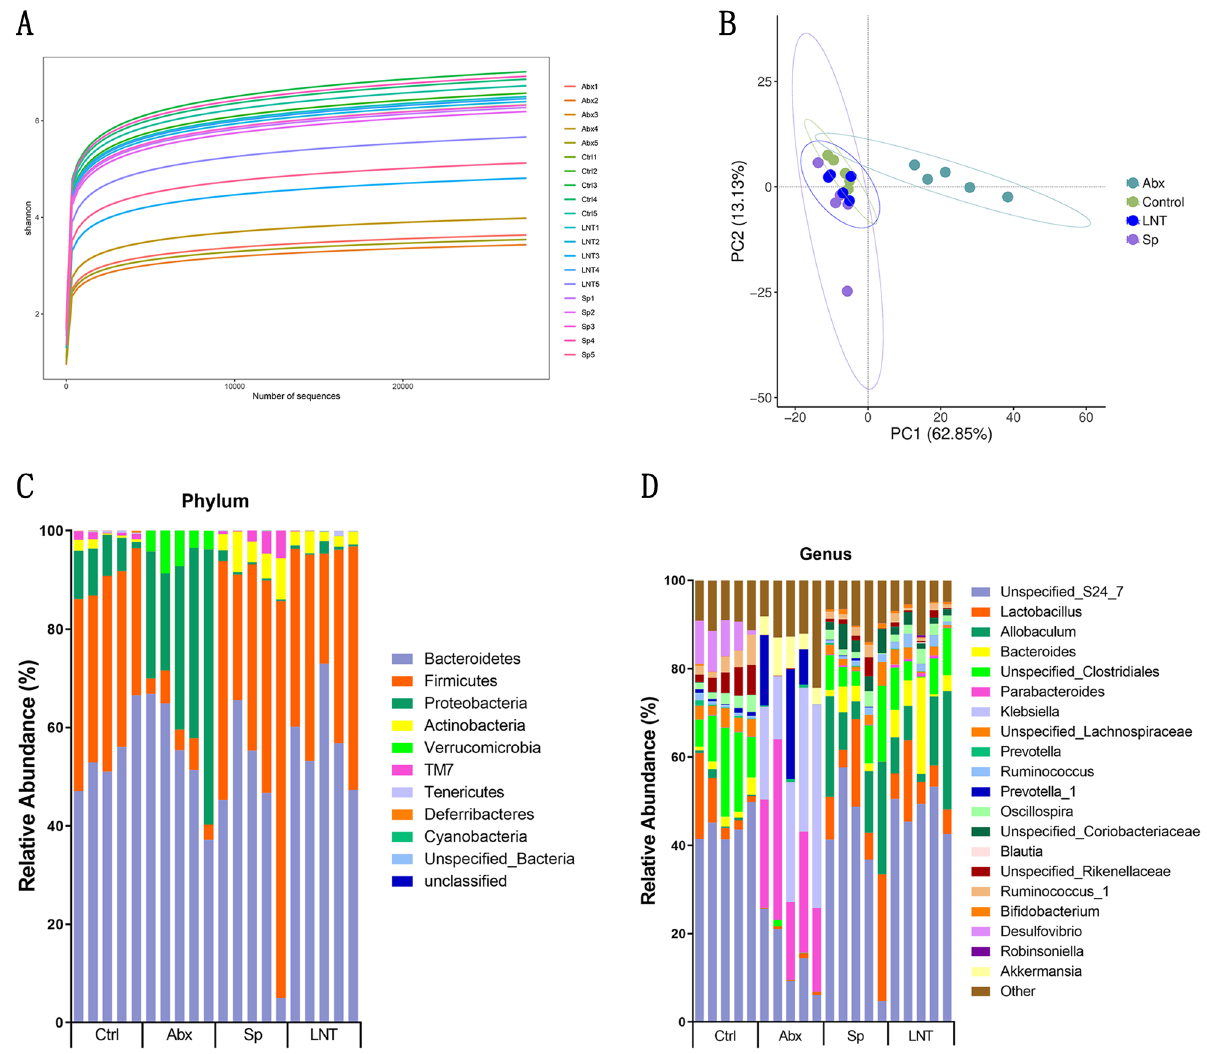
Figure 5. Effect of the gut microbiota. ( A ) Comparison of alpha diversity for mice. ( B ) Comparison of Beta diversity for mice. ( C ) Relative abundance of the Phyla and Genera